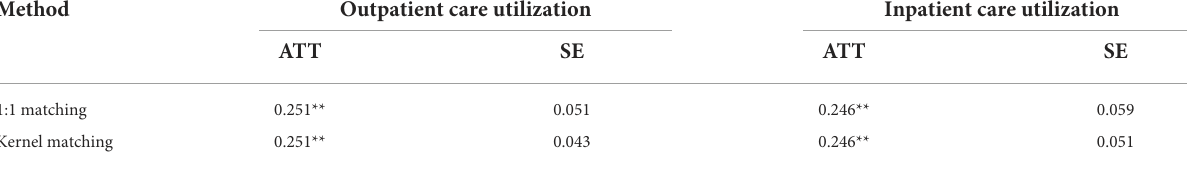
TABLE 4 Average treatment effect (ATT) on the treated (with access to community-based diabetes examination).